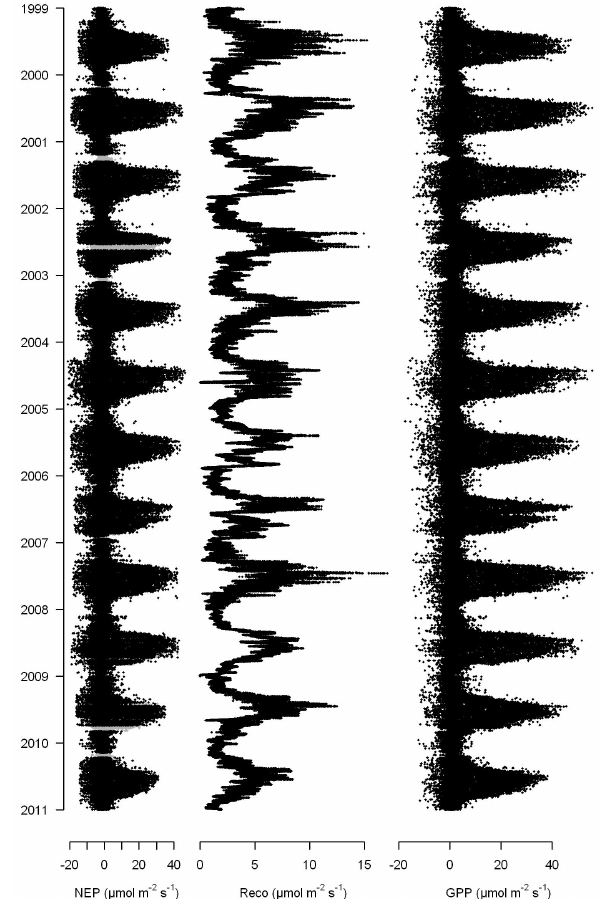
Fig. 2. Half-hourly average values of quality-controlled (black sym- bols) and gap-filled (gray symbols) NEP, R eco and GPP for the pe- riod 1999–2010, at the oak plantation, Straits Inclosure, Alice Holt